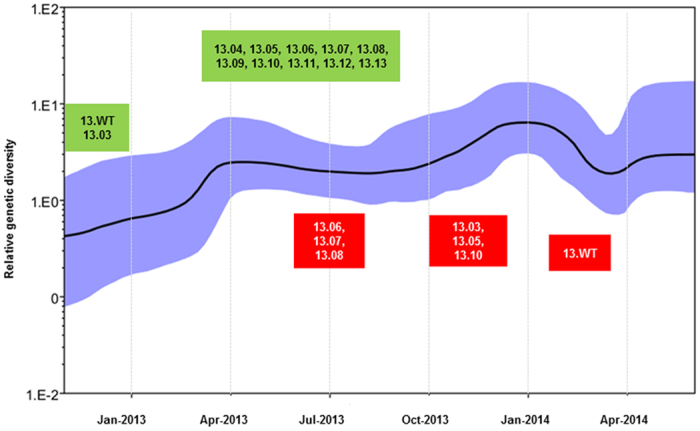
Temporal variation of virus diversity and emergence/disappearance of variants.Bayesian skyline plot was generated in the BEAST package v1.7.451 using a TN93+I+G substitution model together with an uncorrelated log-normal relaxed molecular clock and a Bayesian skyline coalescent model. One hundred million generations of MCMC chains were run with sampling at every 10,000 generations. The black line illustrates the fluctuations in median genetic diversity over time and the shaded area represents 95% highest posterior density (HPD) values. Green and red boxes indicate the time of emergence and extinction of variants included within each box respectively. D1GIII = DENV-1 genotype III; n = number of sequences per each variant used in the analysis; WT = wild type.